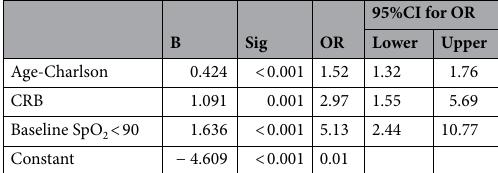
Table 6. Multivariate model for predicting death.